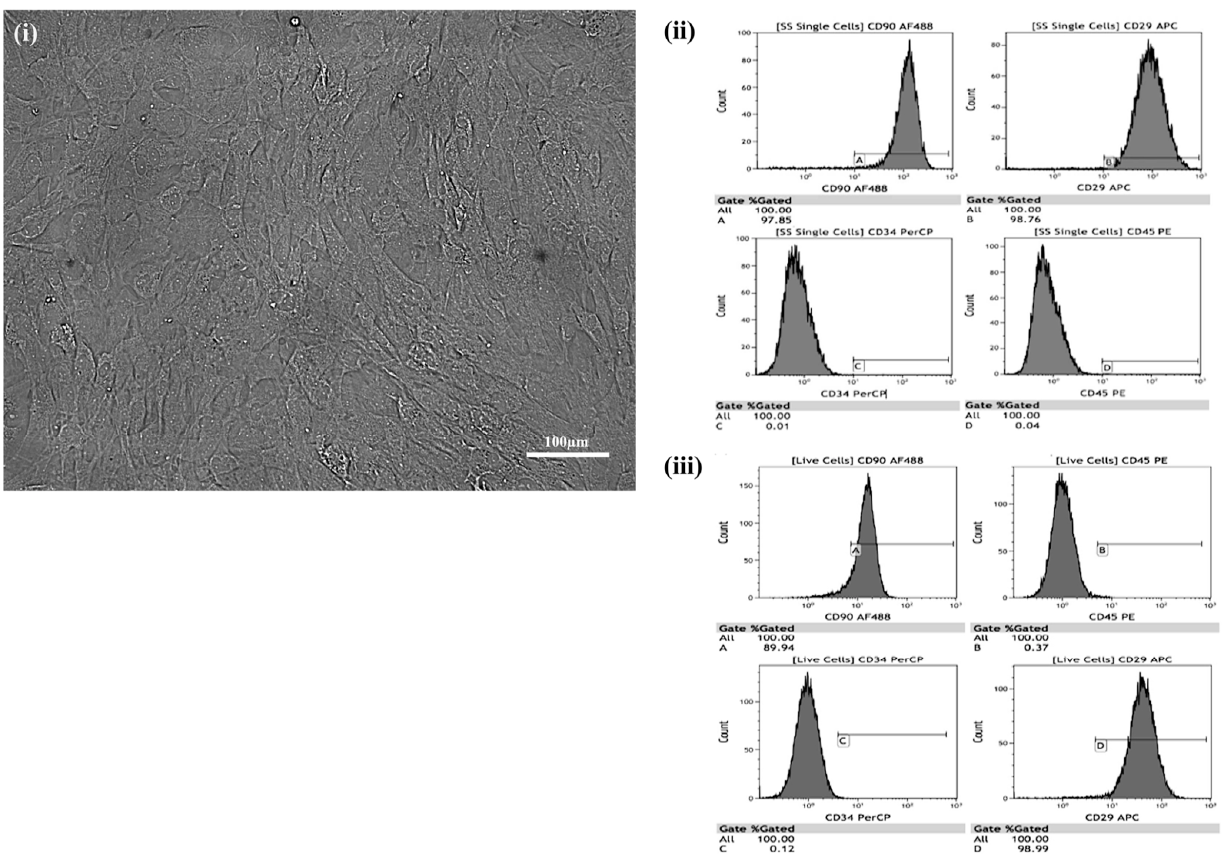
Figure 1. Characterization of cultured adipose-derived-mesenchymal stem cells (AD-MSCs). ( i ) Phase-contrast image. ( ii , iii ) Fluorescence-activated cell analysis ( ii , A – D ), including live cell analysis ( iii , A – D ), of cluster of differentiation (CD) expression (dark grey) by cultured (passage 4) adult-sourced AD-MSCs.